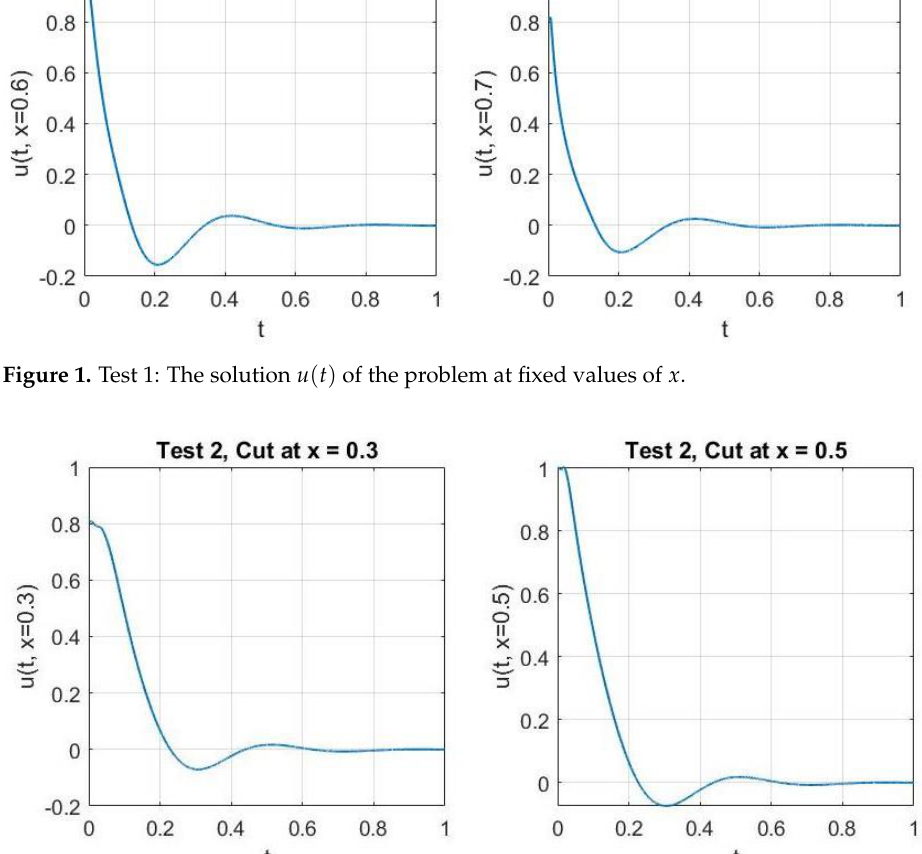
Figure 2. Test 2: The solution u ( t ) of the problem at fixed values of x . Figure 3. Test 1: The energy decay.